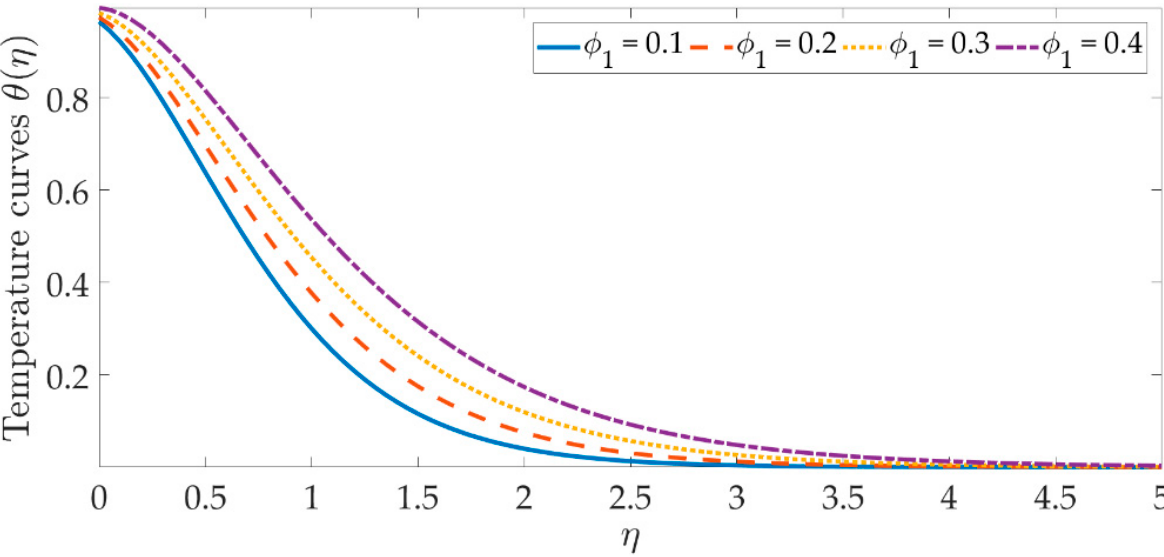
Figure 6. Temperature curves against the multiple values of φ 1